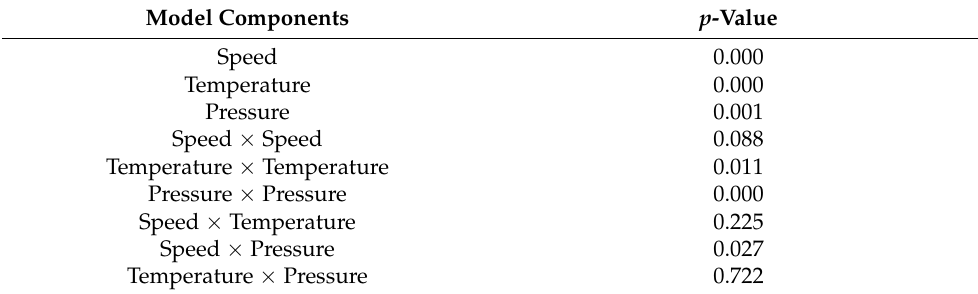
Table 3. ANOVA for the first model.